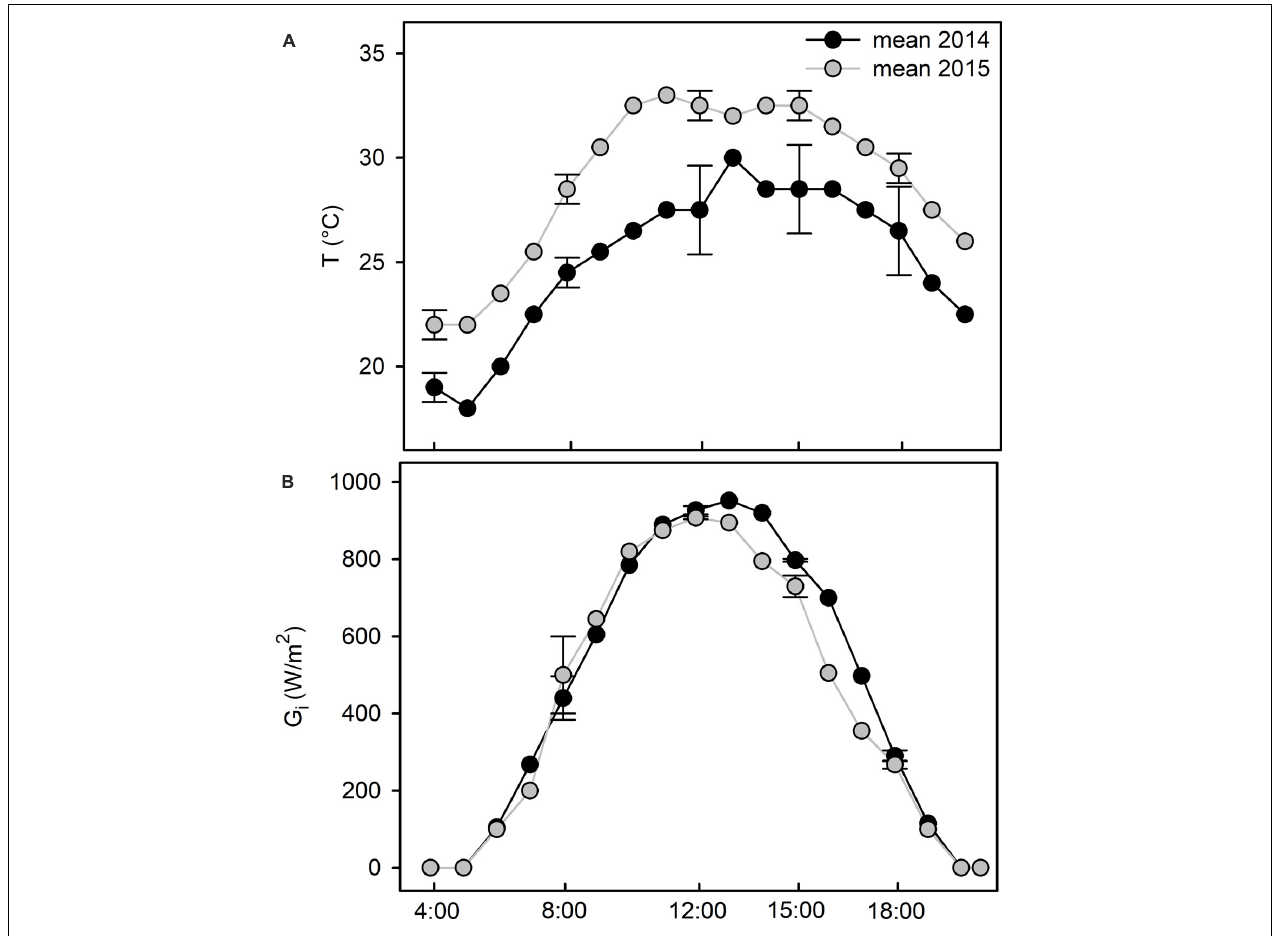
FIGURE 1 | Time course of average air temperatures (T, ◦ C) (A) and of global irradiance (G i , Wm − 2 ) (B) of the sampling days in July 2014 (black line) and July 2015 (gray line). Data of the weather station “Grosseto” (Italy) from the regional archive of the LaMMA Consortium